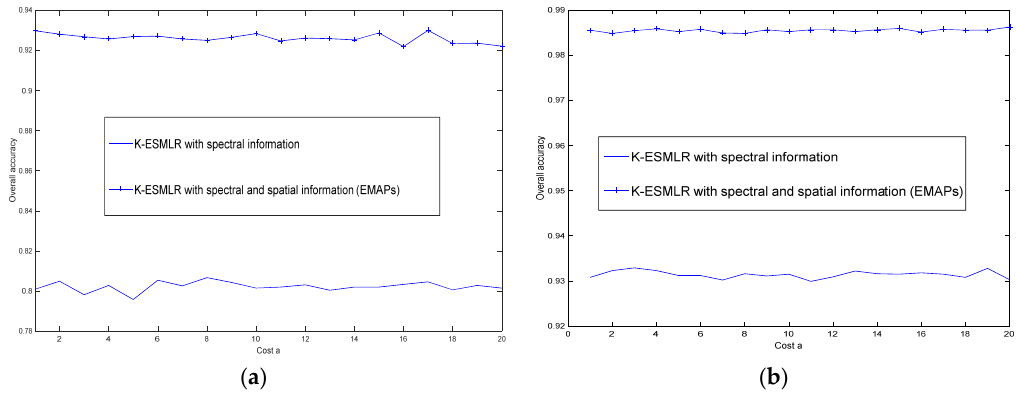
Figure 4. The robustness of the proposed framework under different values of cost C: ( a ) The proposed ESMLR with the Indian Pines dataset (using the original HSI dataset, i.e., 200 features, b = − 15) and the K-ESMLR with the EMAPs (36 features, b = − 17); ( b ) The proposed K-ESMLR with the Pavia University dataset (using the original HSI dataset, i.e., 103 features, b = − 10) and the K- ESMLR with the EMAPs (36 features, b = − 12).